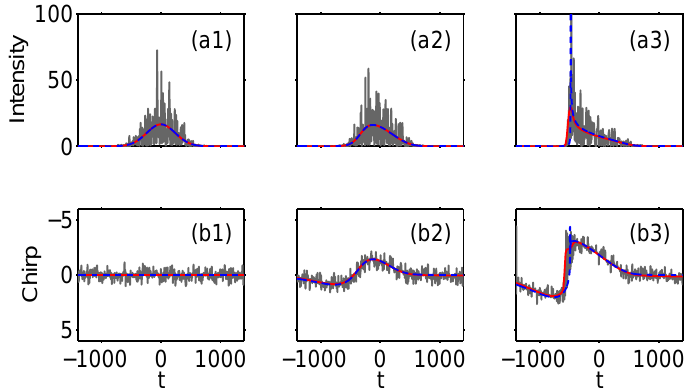
Figure 8. Anomalous dispersion regime: Numerical simulations of the NLS equation (1) (gray line), of the Vlasov Equation (2) (red line), and of the hydrodynamic-like Equations (3) and (4) (blue line). In analogy with the normal dispersion regime (Figure 1), the evolution of the intensity of the field develops a collapse singularity ( a ), while the momentum (chirp) develops a shock singularity ( b ). The good agreement between the different models is obtained without using adjustable